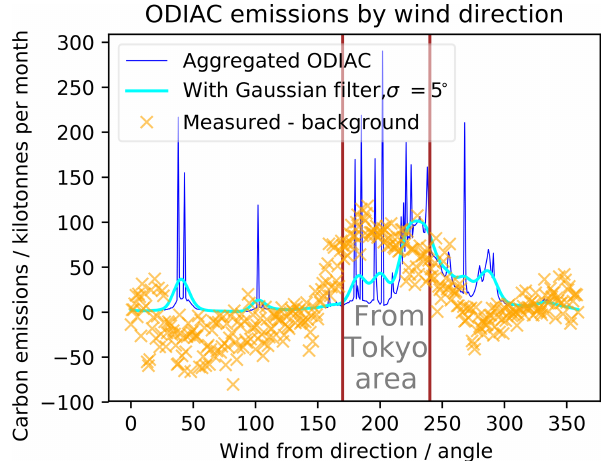
Figure 7. Sum of ODIAC carbon emissions by direction in angular degrees as seen from Tsukuba, Japan. The “aggregated ODIAC” emissions show emissions per direction from the beginning of 2011 to the end of 2016. The Gaussian filter data use a moving average to estimate signals measured at a distance. The measured dataset shows the median residuals from Fig. 5 for